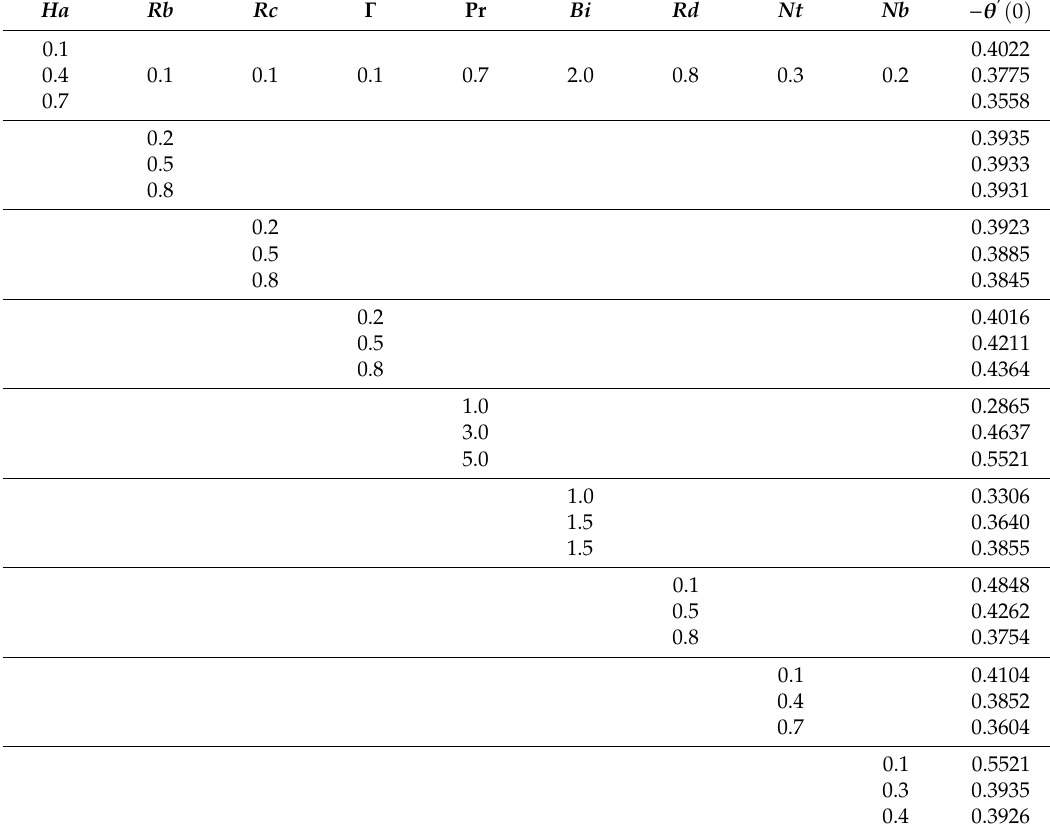
Table 3. Variation in local Nusselt number − θ (cid:48) ( 0 ) for Ha , Rb , Rc , Γ , Pr, Bi , Rd , Nt and Nb